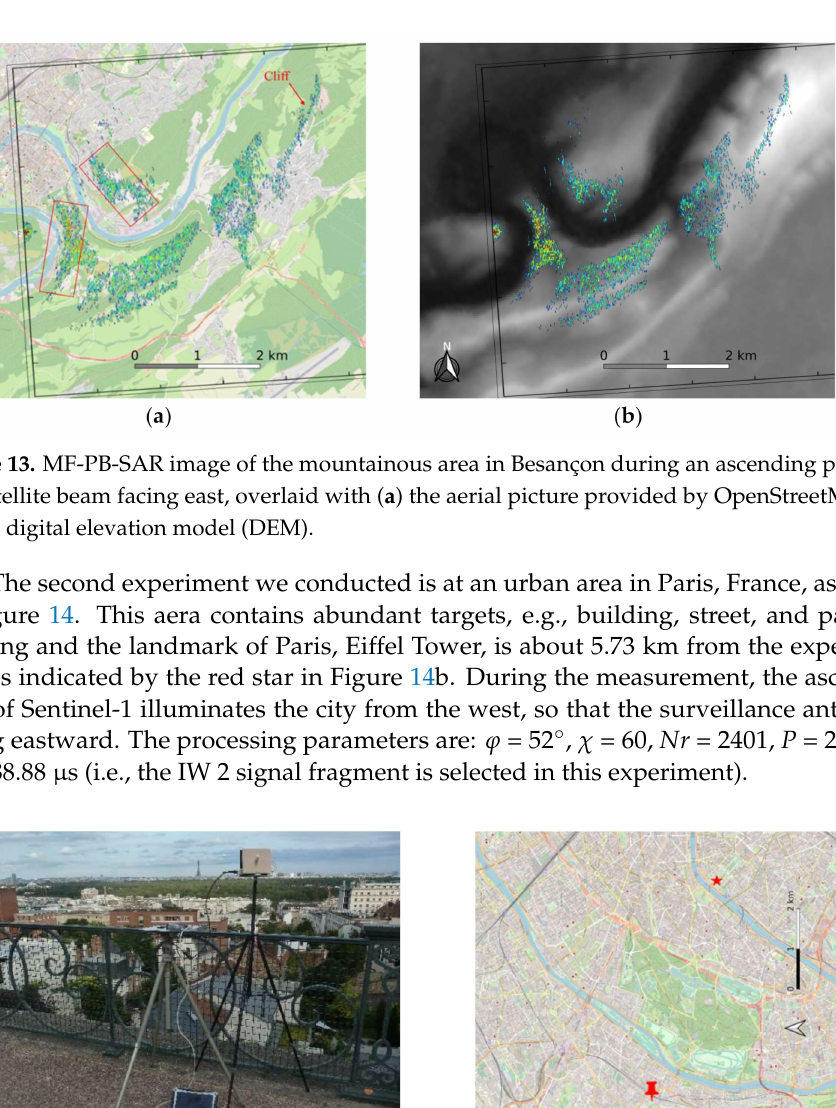
Figure 12. MF-PB-SAR images of the mountainous area in Besançon on ( a ) the α -o- β plane and ( b ) the x-o-y plane, obtained by the linear interpolation process.